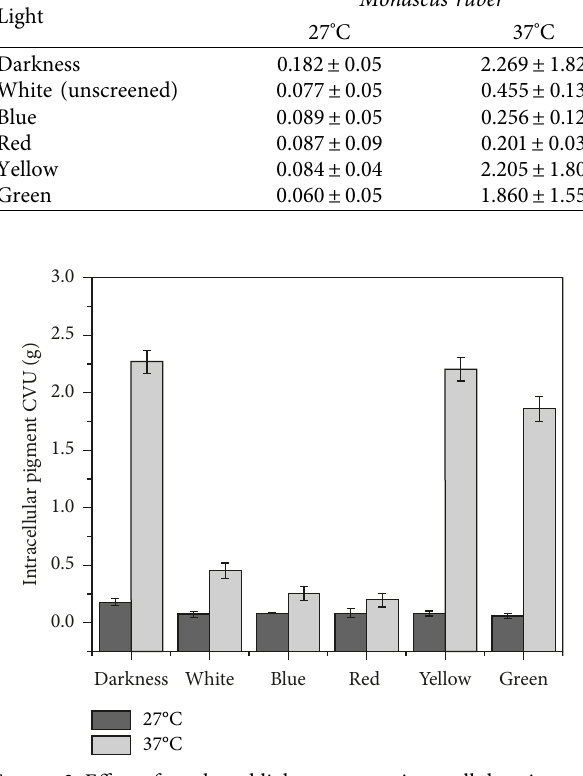
Figure 2: Effect of an altered light source on intracellular pigment yield by Monascus ruber at 27 ° C and 37 ° C.